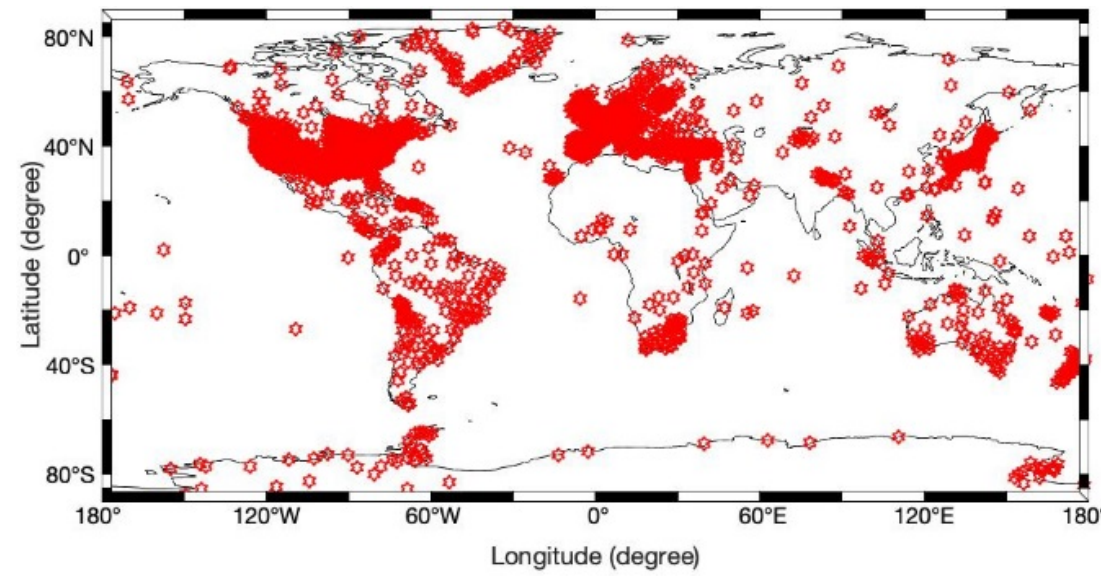
Figure 2. Distributions of the 4072 global positioning system (GPS) sites for the study of GIA crustal uplift rates.